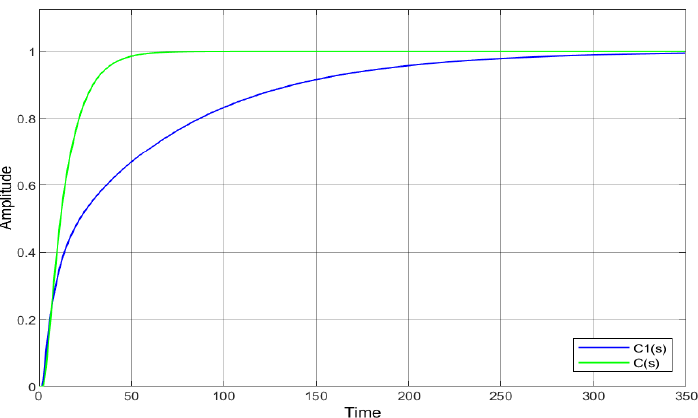
Figure 15. Simulated response under a desired reference step using two different controllers in the closed-loop system shown in Figure